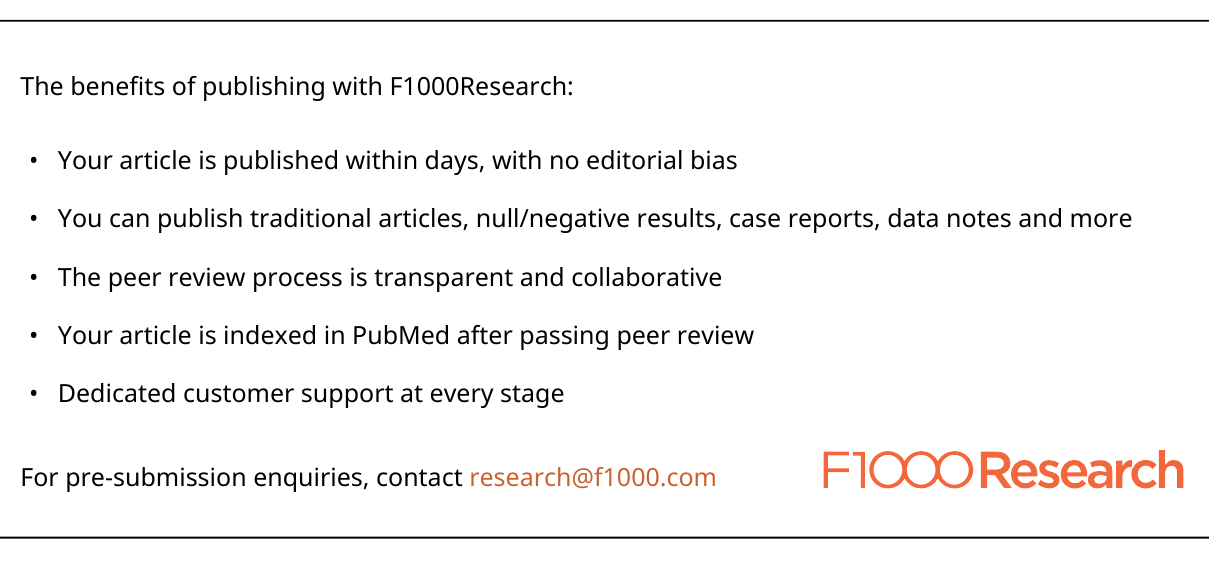
Figure 3 is unclear. Is this for anybody returning from a Gulf State or only those returning with symptoms? The first diamond makes this